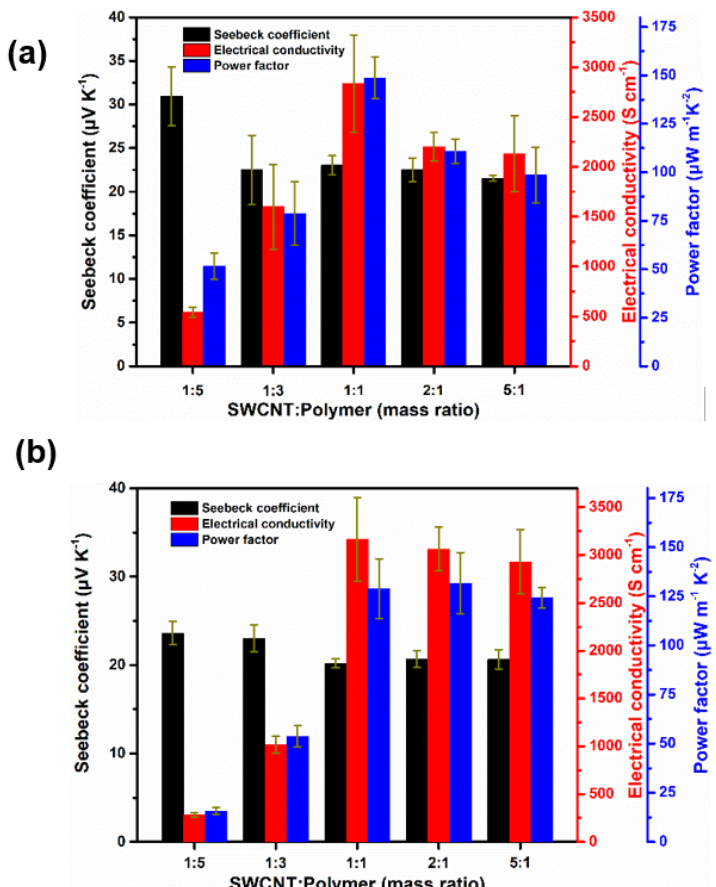
Figure 6. Electrical conductivities, Seebeck coefficients, and power factor values of P1 /SWCNT ( a ) and P2 / SWCNT composite films ( b ).